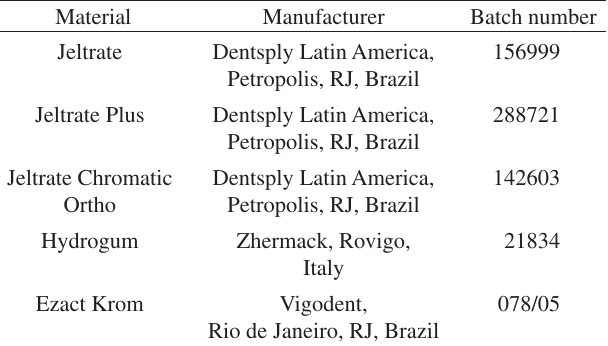
Table 1. Materials tested, manufacturer, and batch number. Material